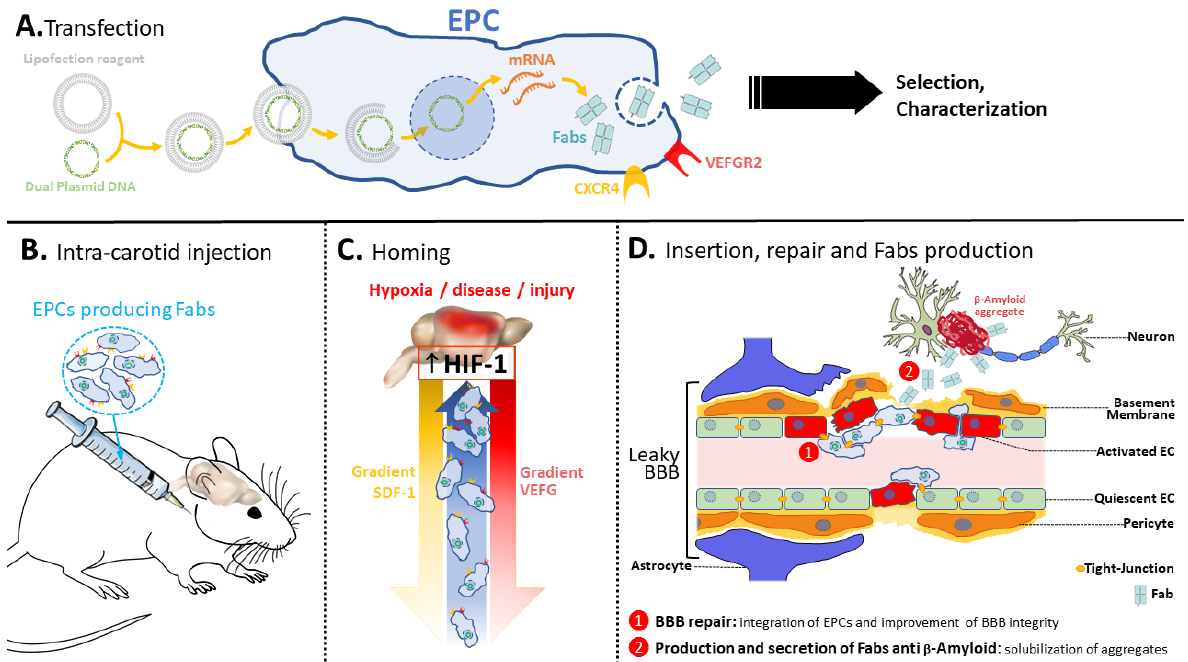
Figure 1. Therapeutic concept. Taking AD as example, the strategy is to combine a cell therapy using the EPCs and the immunotherapy with the secretion of anti- β -amyloid Fabs. After transfection ( A ), the Fab producing EPCs are selected and characterized before being injected into the mice (old or AD mice) ( B ). The transfected EPCs then home to the brain ( C ) where they secrete the solubilizing Fabs ( D ). This system has a dual function: (1) the EPCs themselves, homing to the hypoxic vessels of the pathologic brain and integrating the BBB, repair the damaged BBB occurring in AD, and (2) transfected EPCs secrete, at the BBB, anti- β -amyloid Fabs capable of solubilizing the aggregates.